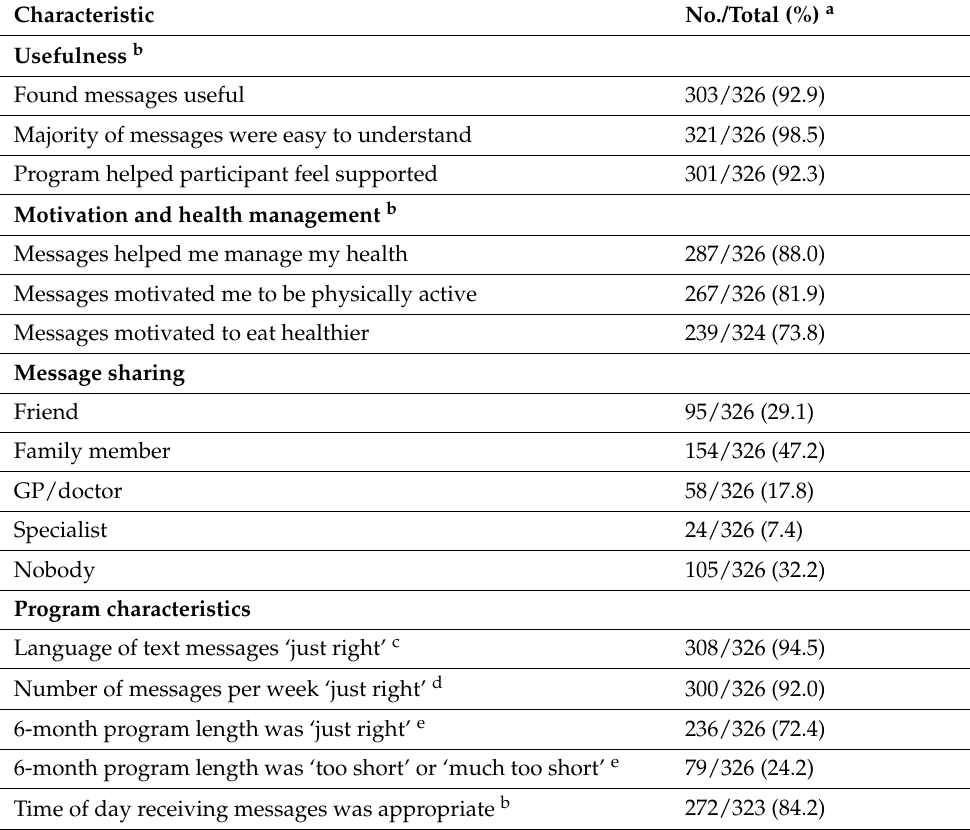
Table 2. Perceived acceptability and usefulness of the Texting for Wellness: Lung Support